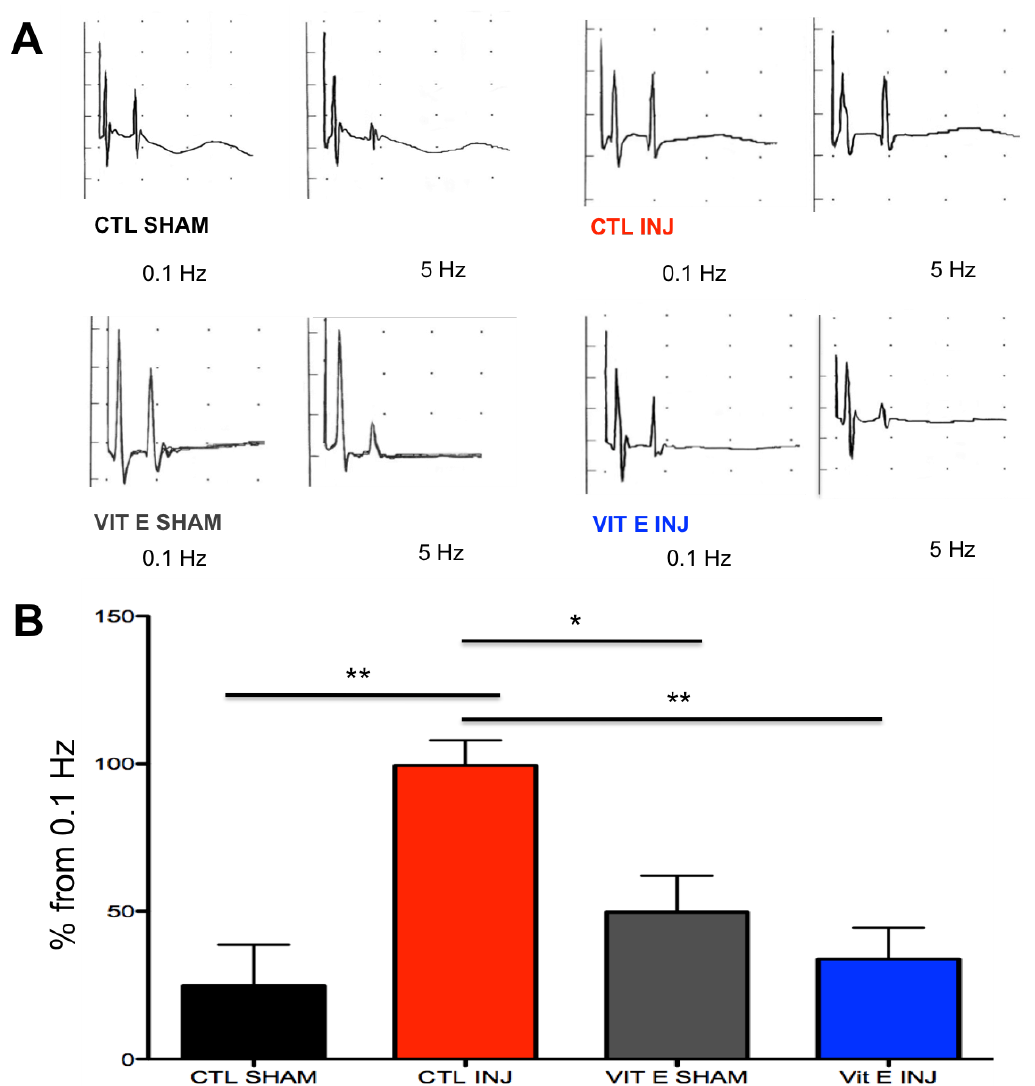
Figure 3. Dietary vitamin E prophylaxis restores H-reflex depression at 7 dpi at 5 Hz. Increased amplitudes on the y axis at 5 Hz indicate less H-reflex rate depression, whereas decreased amplitudes indicate more rate depression. The H-reflex depression after increased frequency (i.e., 5 Hz) was abnormal in rats on a control diet after SCI but it was restored in rats on dietary vitamin E prophylaxis after SCI at 7 dpi ( A ). Higher percent changes from 0.1 Hz at 5 Hz indicate abnormal H-reflex rate depression after SCI in rats on a control diet but not in rats on dietary vitamin E prophylaxis at 7 dpi where there was a lower percent change from .1 Hz ( B ). (** p < 0.01 CTL SHAM vs. CTL INJ and CTL INJ vs. VIT E INJ and * p < 0.05 VIT E SHAM vs. CTL INJ; CTL SHAM n = 6, CTL INJ n = 6, VIT E SHAM n = 6, VIT E INJ n = 7)